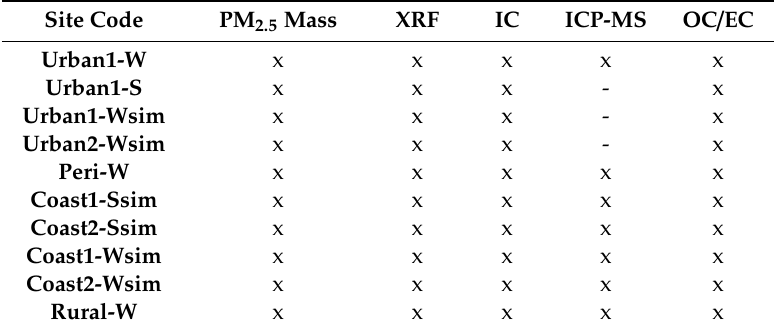
Table 2. Analytical determinations carried out on Teflon and quartz membrane filters sampled at each sampling